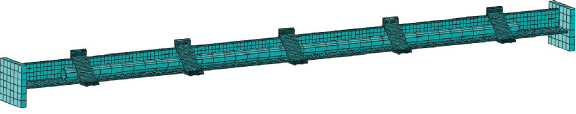
Figure 2: Finite element